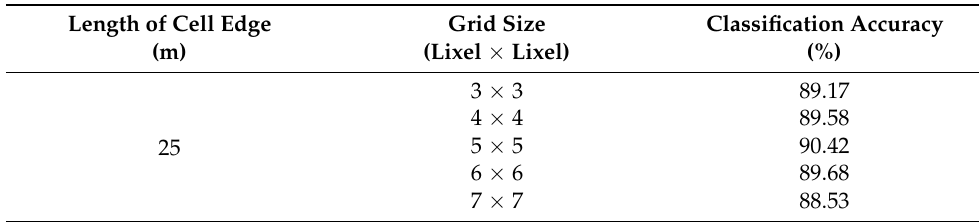
Table 4. Classification accuracies of the proposed model using GSCDs with different grid sizes. Length of Cell